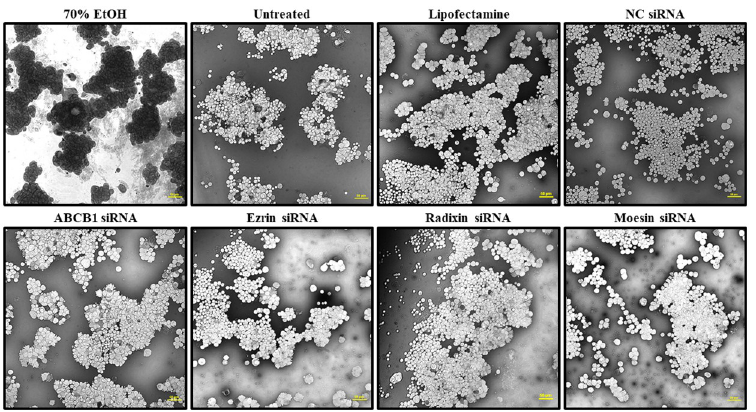
Fig 7. Effect of siRNA treatment on passive transport in LS180 cells. The phase-contrast images of Evans blue accumulation in LS180 cells pretreated with 70% ethanol (EtOH) to disrupt the plasma membrane integrity and of those treated with siRNAs targeting ABCB1, ezrin, radixin, or moesin for 3 days. Scale bars: 50 μ m. All the images are representative of at least three independent experiments.